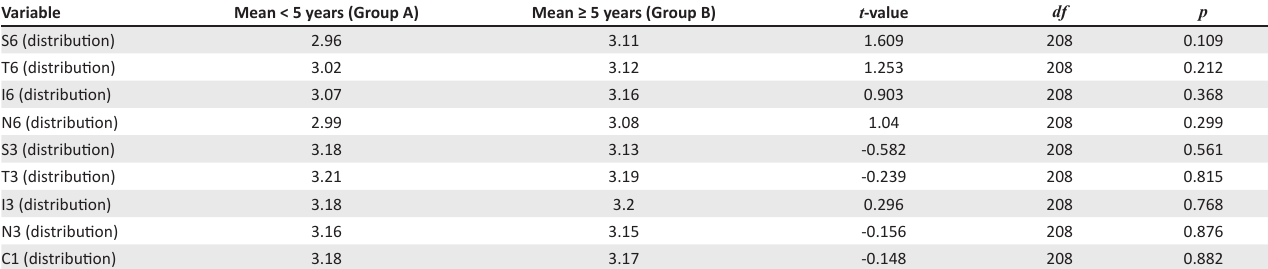
TABLE 3: Macula map thickness distributions compared with a t -test for independent samples between Groups A (107 values) and B (103 values).